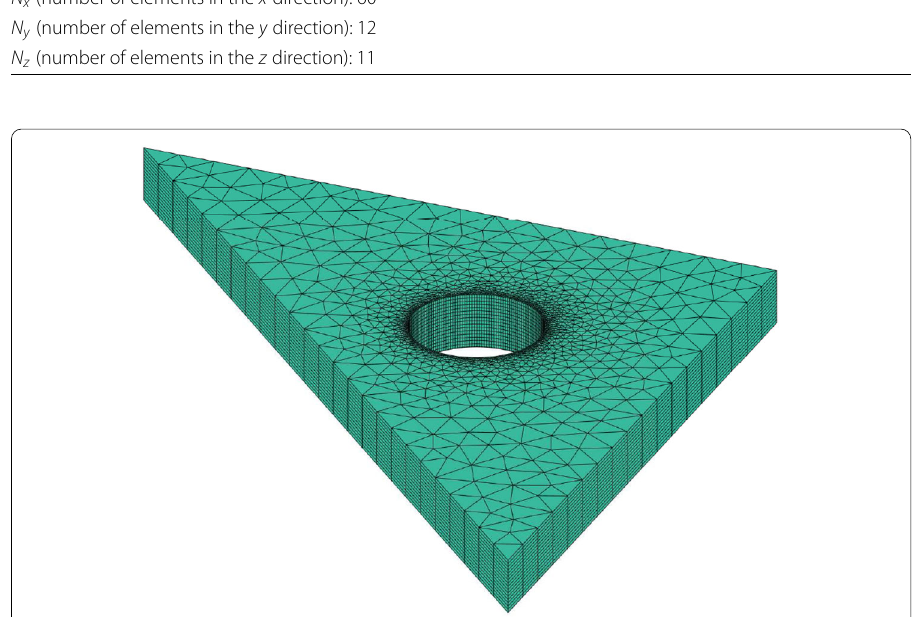
Fig. 7 Holed 3D triangular element and its associated